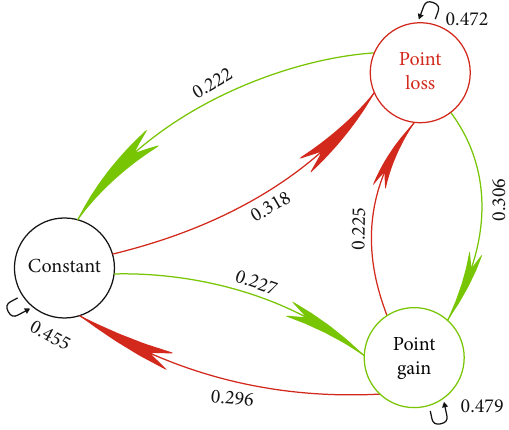
Figure 5: Ecobank equity transition matrix and diagram.